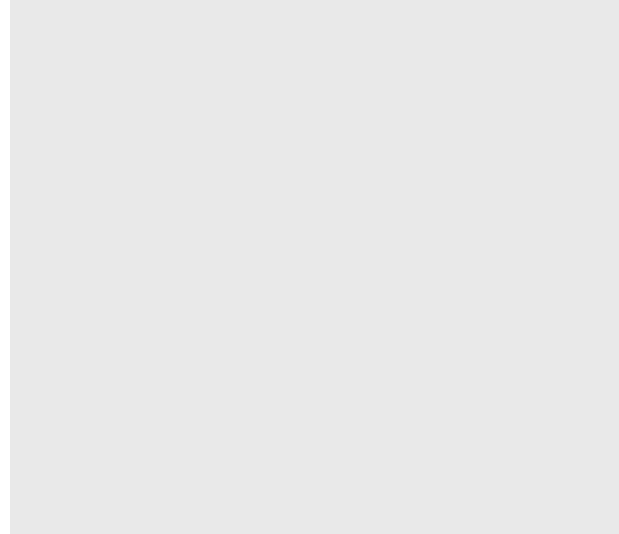
FIGURE 3 - Incidence of AFs showing the importance of regular monitoring and a more stringent food safety system to effectively control the AFs at the lowest possible levels in peanuts and cashew